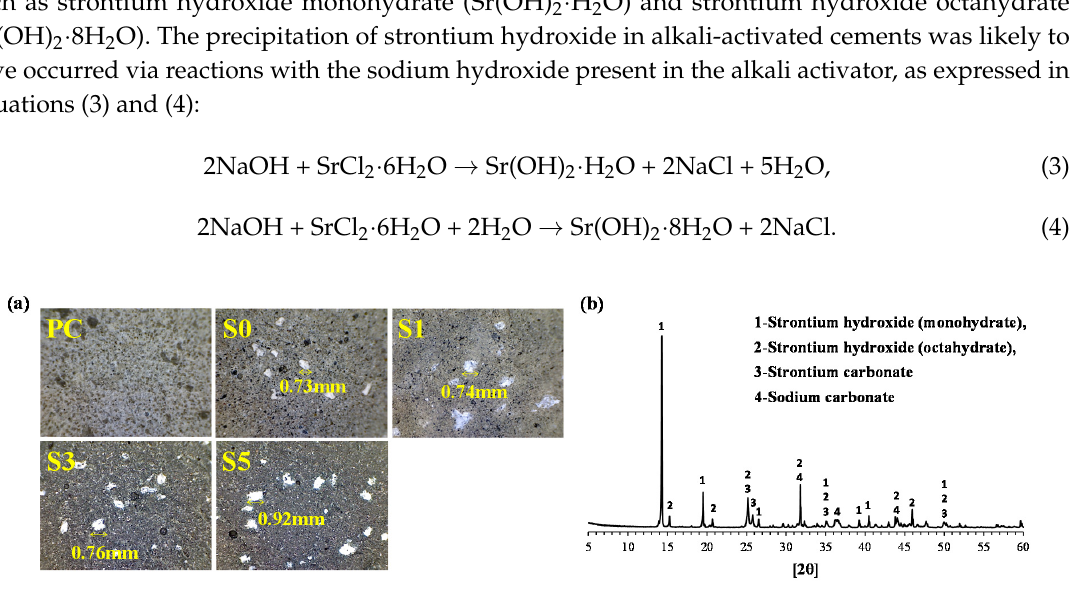
Figure 1. The precipitates formed in the binder matrix incorporating cesium and strontium: ( a ) microscope images and ( b ) X-ray diffraction peak patterns of the